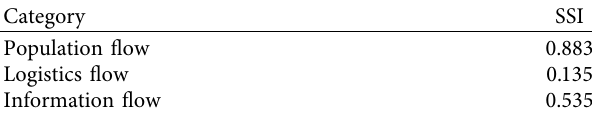
Table 2: Spatial structure index (SSI) of the three types of